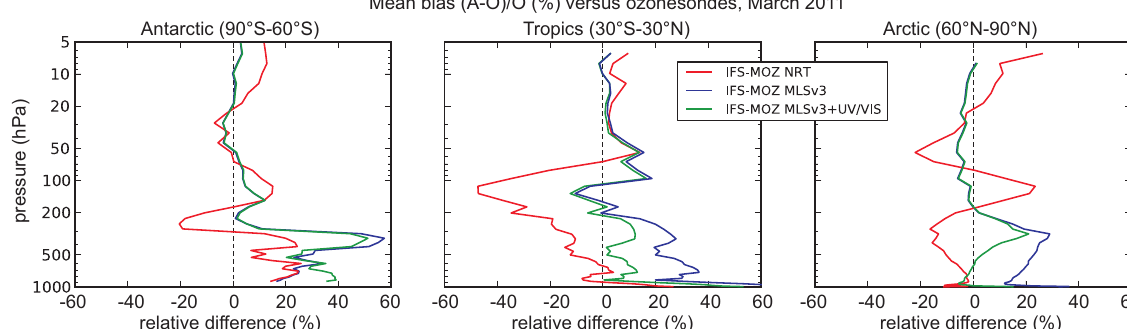
Figure 12. Mean biases, in %, of three ozone analyses by IFS-MOZART using O 3 sonde profiles as reference, for March 2011. Results are shown for the Antarctic (left), tropics (centre) and Arctic (right) latitude bands using the IFS-MOZART NRT analyses (red lines), the offline experiment assimilating only MLS v3 (blue lines) and another offline experiment assimilating MLS v3 and the UV–Vis observations (green lines). See text for